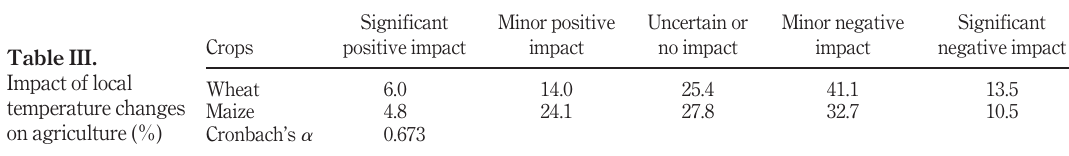
temperature changes on agriculture